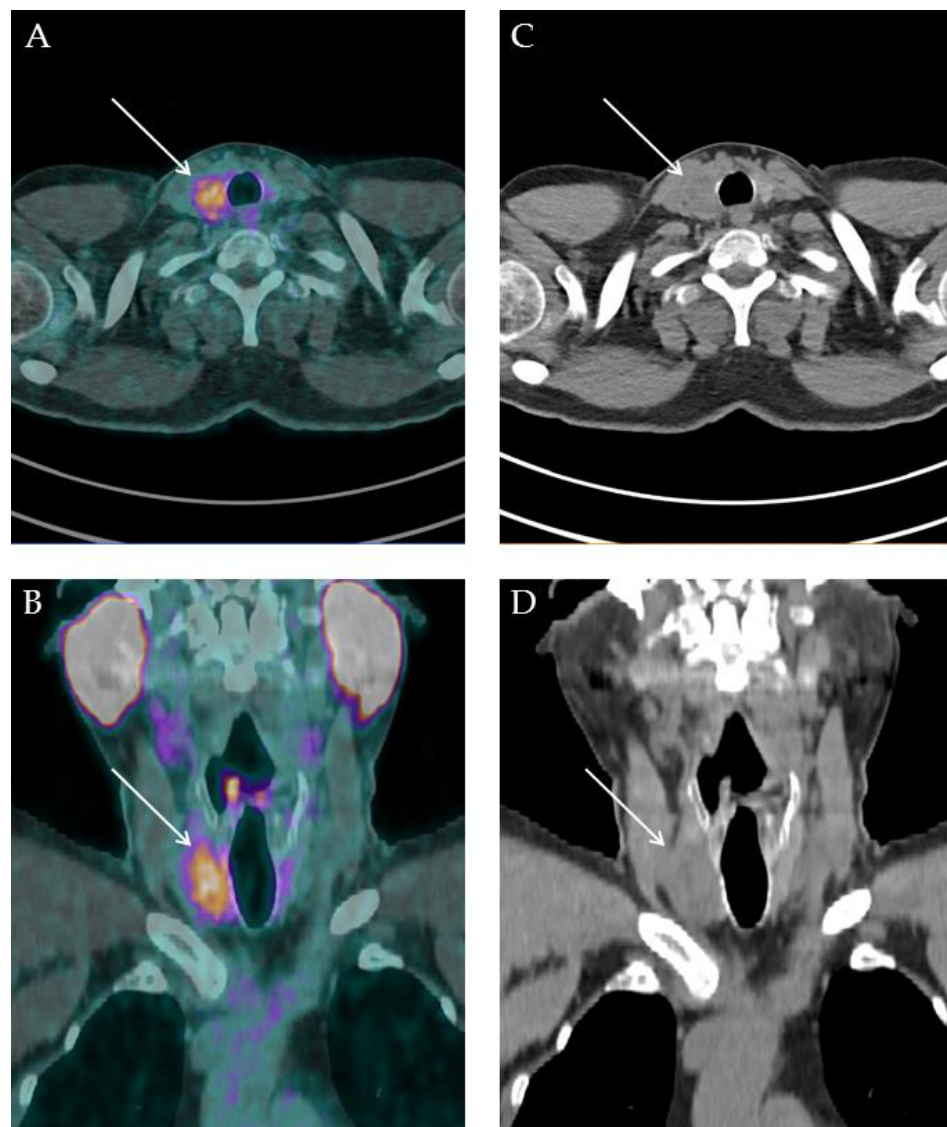
Figure 2. A 57-years old man with diagnosis of prostate adenocarcinoma previously treated through external beam radiation therapy in 2019 (Gleason score 4 + 4) came to our attention in December 2021 for biochemical recurrence (PSA value: 0.91 ng/mL) and underwent restaging 18 F-PSMA-1007 PET/CT. PET/CT scan was performed 90 min after 270 MBq 18 F-PSMA-1007 ad- ministration. PET/CT images showed focal uptake in the prostate gland right lobe, attributable